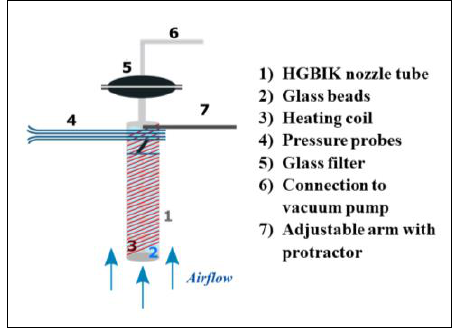
Fig. 18. Schema of the HBIK